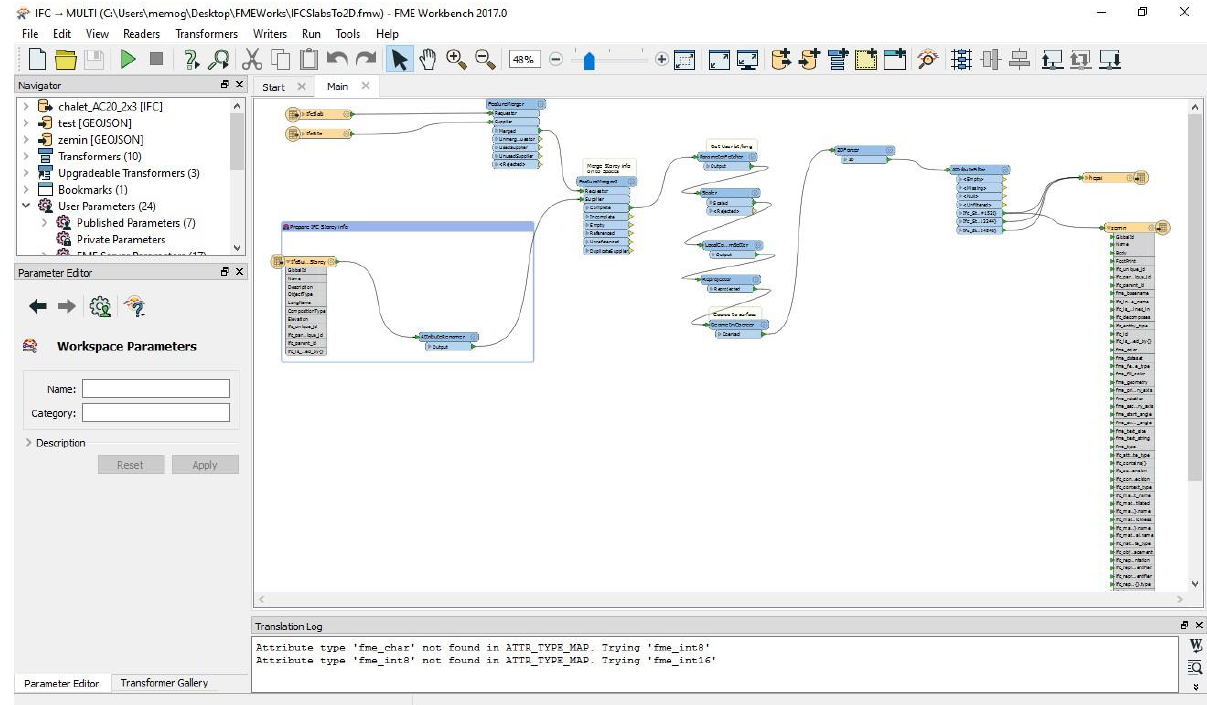
Figure 2. Transformation of Information Using FME